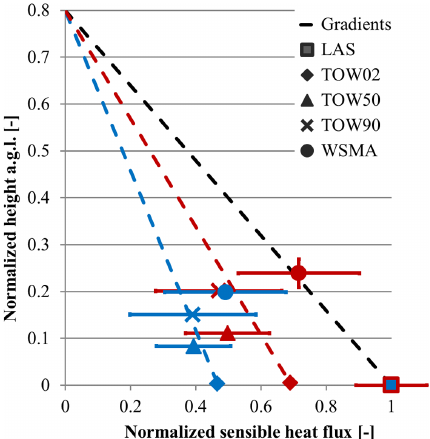
Fig. 8. Vertical profile of the sensible heat flux during two flights: 20 October 2008, 10:53–10:55UTC (red) and 21 October 2008, 09:56–09:59UTC (blue). Heat fluxes are compared between large- aperture scintillometer (LAS), tower eddy covariance at 2.4m, 50m and 90m (TOW02, TOW50, TOW90) and the weight-shift micro- light aircraft (WSMA). Where available, error bars show the ran- dom statistical error and the altitude standard deviation. Additional information is given in the text.